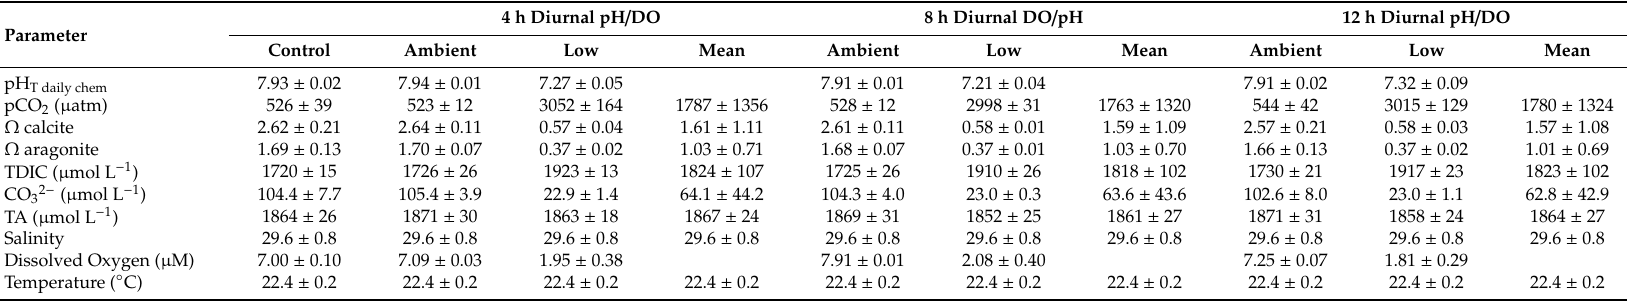
Table 8. Mean ( ± standard deviation) pH, pCO 2 , saturation states of calcite and aragonite, total dissolved inorganic carbon (TDIC), carbonate, total alkalinity (TA), salinity, dissolved oxygen, and temperature for the Menidia menidia four treatment diurnal duration acidification and hypoxia experiments. 4 h Diurnal pH / Parameter